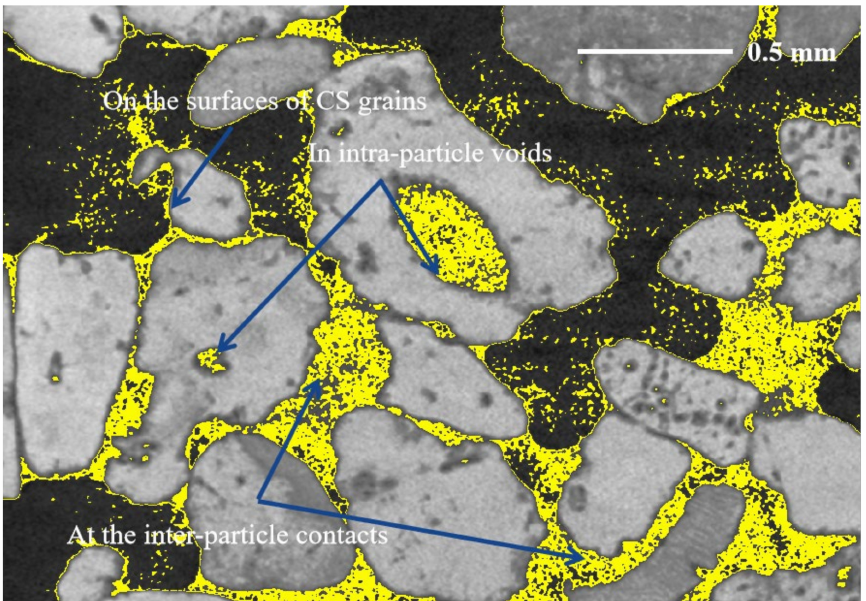
Figure 2. Micro-CT image of the distribution of the THF/water solution in the CS specimen.